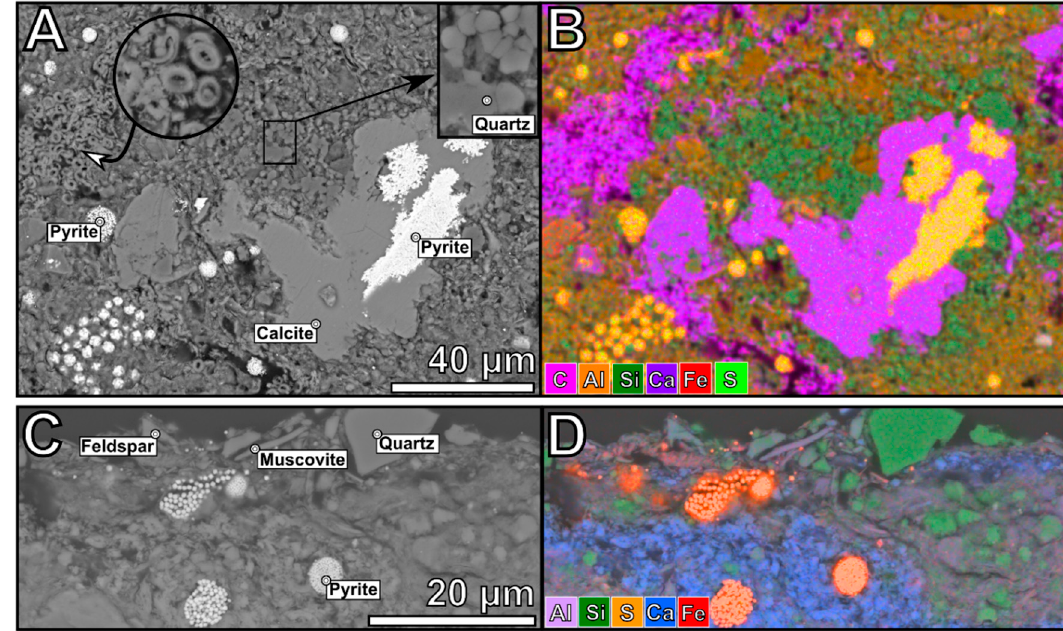
Figure 3. Scanning electron microscope (SEM) image of Draupne Shale (modified after [35]). ( A , B ) show the distribution of microfossils, pyrite, carbonates and quartz. Note the authigenic growth of quartz. ( C , D ) show the presence of detrital quartz, feldspars and micas. Note the smearing of framboidal pyrite along the shear surface. Color-coding in ( B , D ) indicate the position of key-elements shown in ( A , C ) in a grey scale, respectively. Index: C = carbon, Al = aluminium, Si = silicon, Ca = calcium, Fe = iron, S = sulphur.